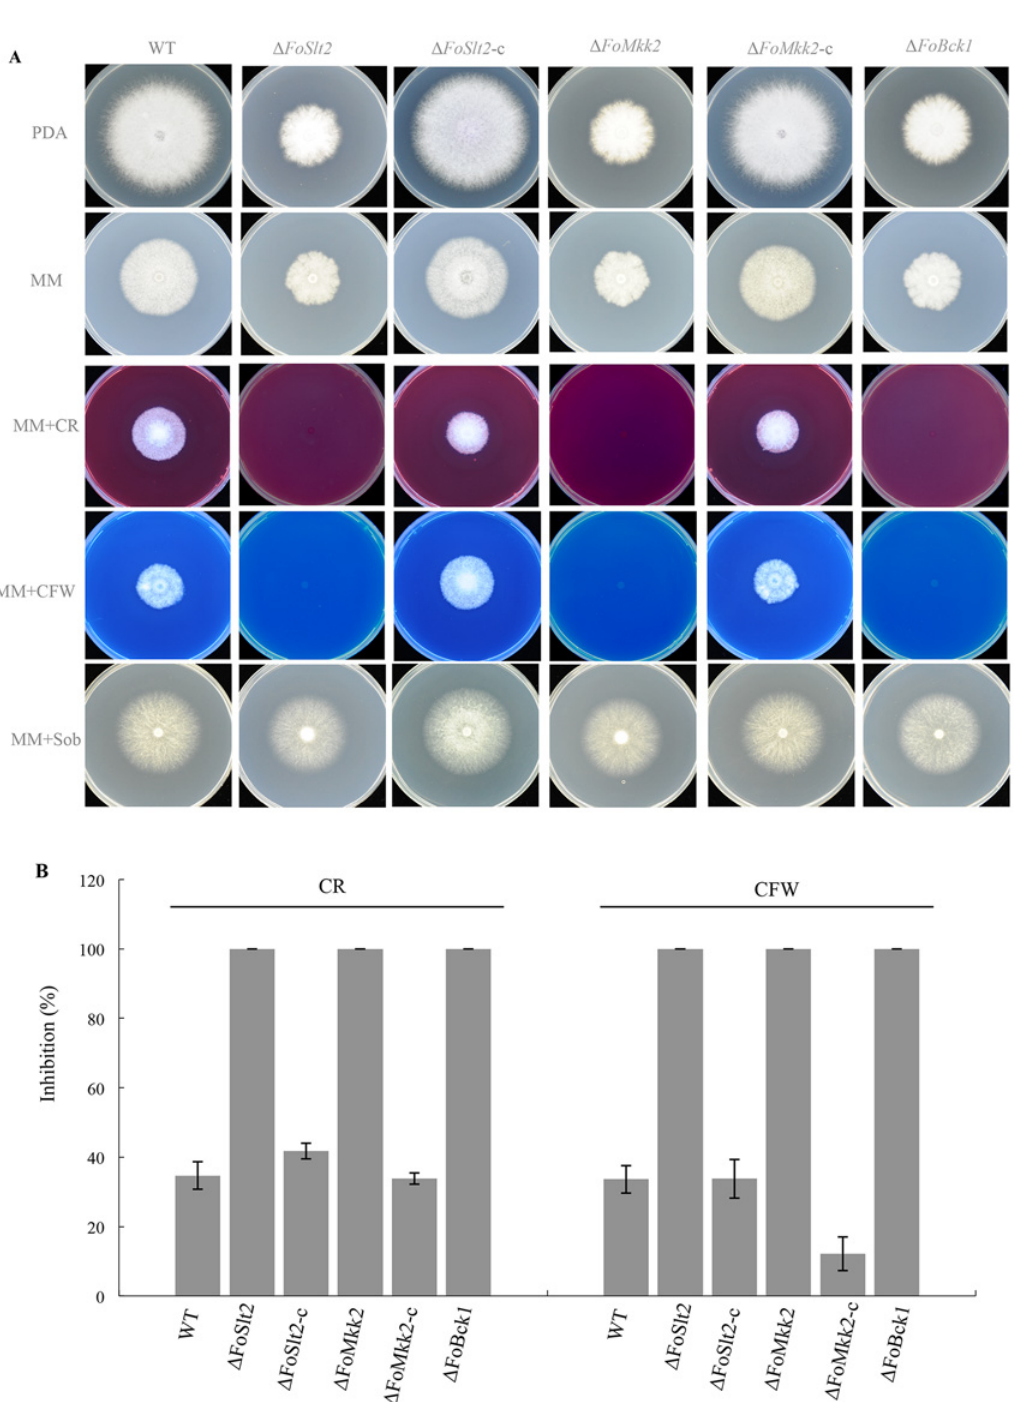
Fig 2. Effects of FoSlt2 , FoMkk2 and FoBck1 genes on cell wall integrity of FOC. (A) Colony morphology of the indicated strains grown on PDA, minimal medium (MM), MM supplemented with Congo Red (CR, 40 μ g/mL), Calcofluor White (CFW, 40 μ g/mL), or sorbitol (Sob, 1.2 M) incubated at 28°C for 6 days on MM plates. (B) Inhibition of the radiated growth of the indicated strains grown on the MM plates. Error bars indicate the standard error from three replicates.